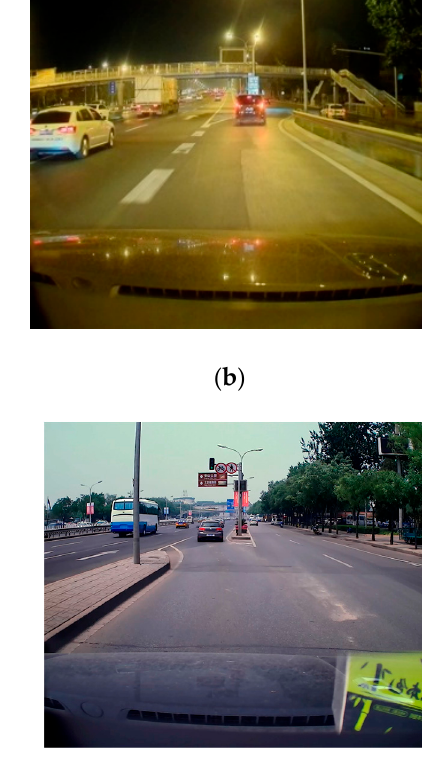
Figure 15. Real-time turning recorded by gyroscopes on urban road ( left ) and highway ( right ). Figure 16 shows the CDF of successful turning detections with detected time. In this study, only lane-changes detected within 2 s from wheels moving (delayed period comparing to ground truth) are defined as a successful detection. Almost 80% of turning is detected within 1 second. The most